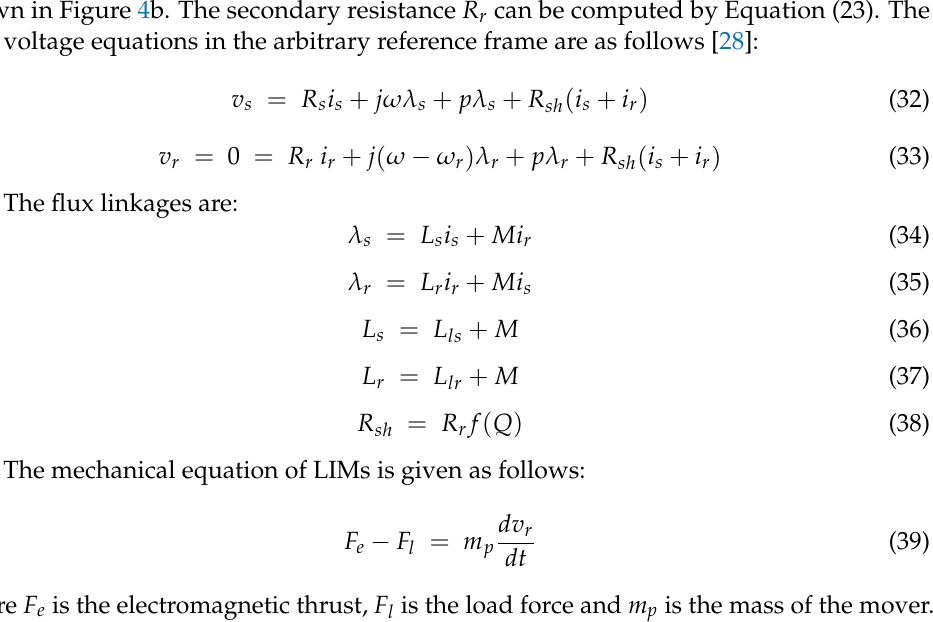
Figure 8. Thrust versus velocity curve.